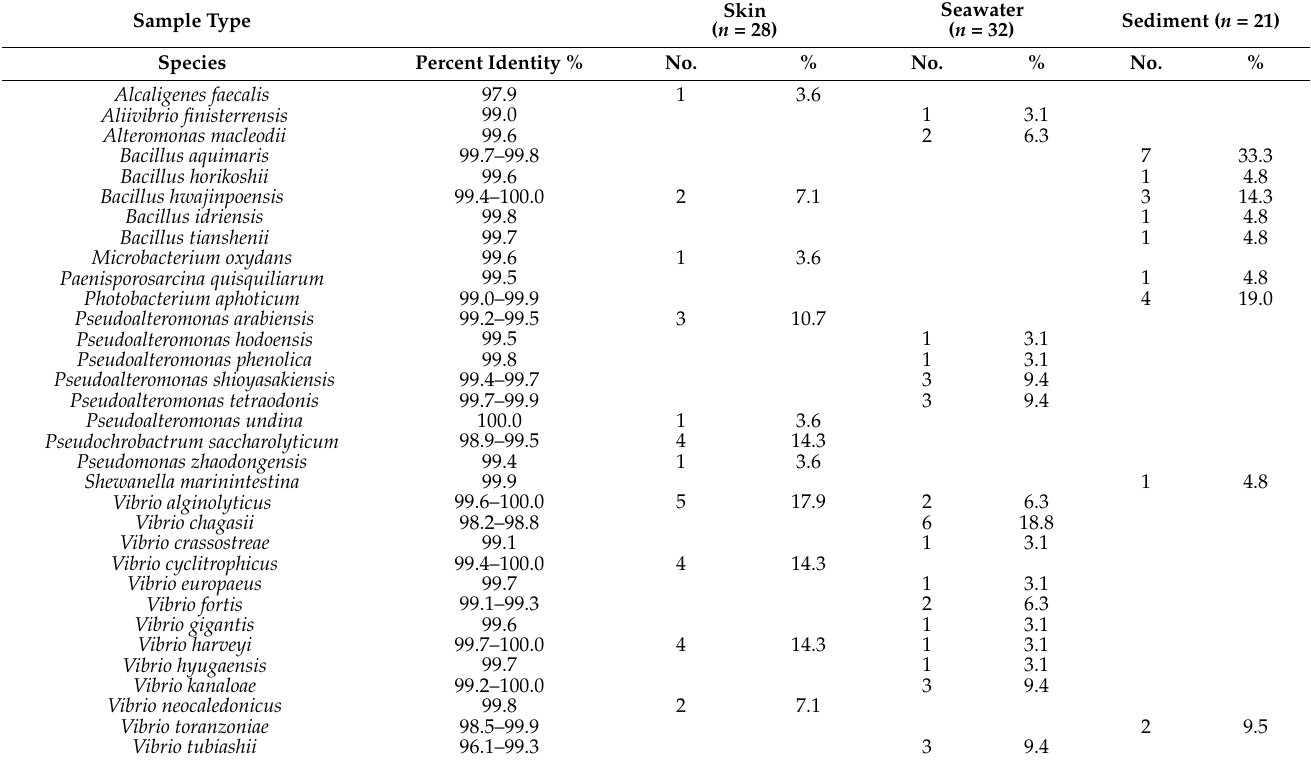
Table 4. Results of molecular identification of bacterial isolates from the NAS antibiotic-free farm. Sample